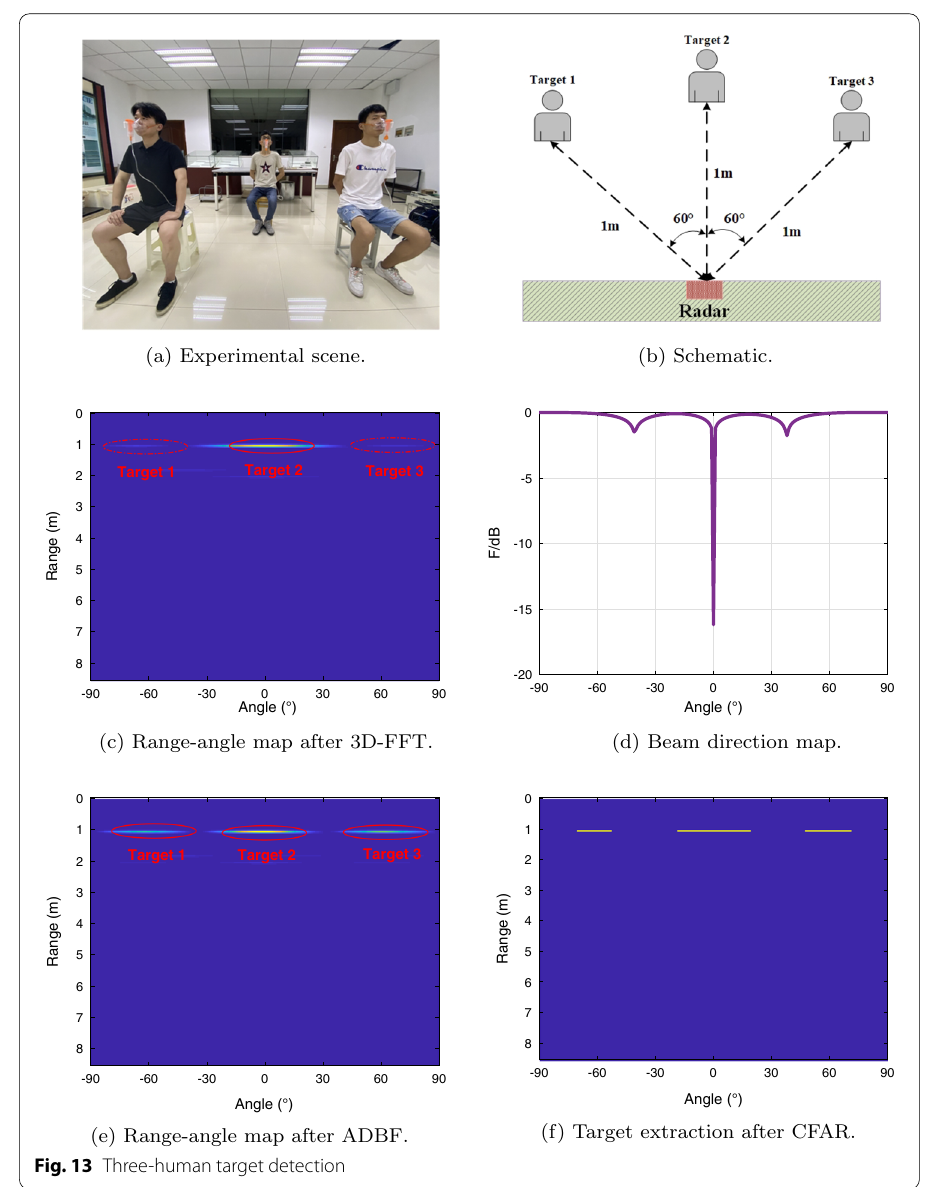
Fig. 13 Three-human target